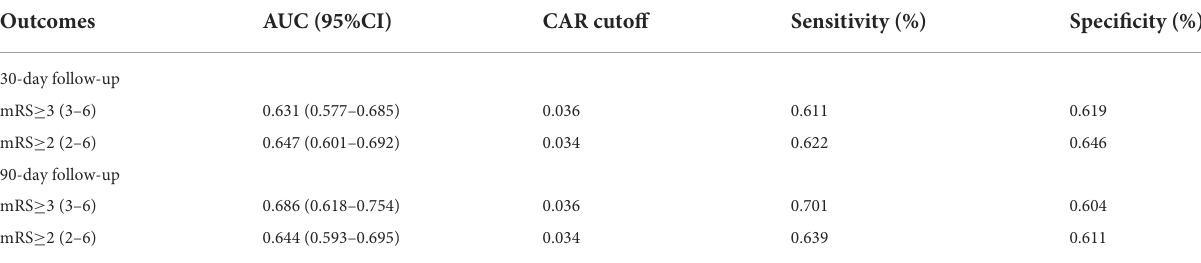
TABLE 4 Predictive values of CAR for adverse clinical